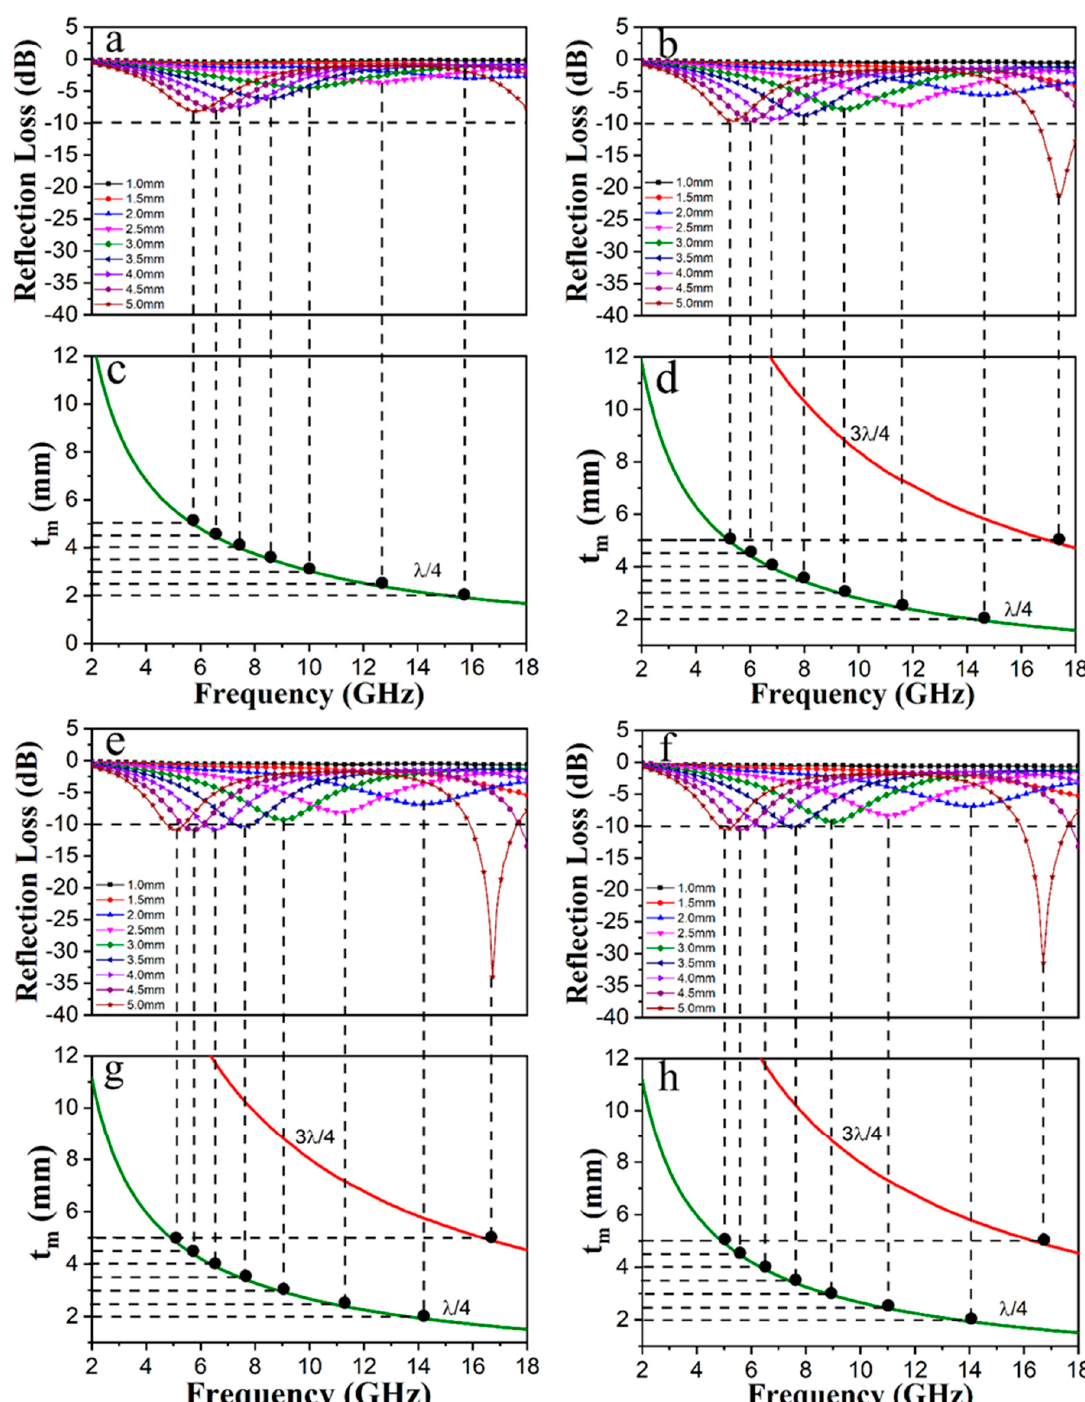
Figure 9. Reflection loss curves of M0 ( a ), M1 ( b ), M2 ( e ), and M3 ( f ). Dependences of matching thickness ( t m ) on matching frequency ( ƒ m ) of M0 ( c ), M1 ( d ), M2 ( g ), and M3 ( h ) simulated with the λ / 4 model.